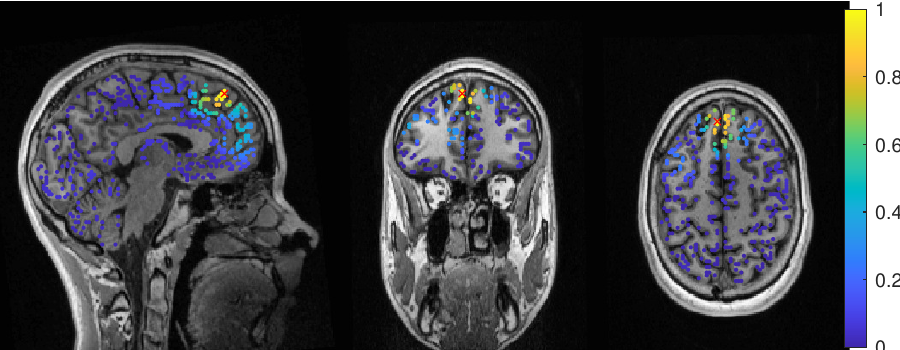
Figure 11. Patient 2’s result of the MEEG average-based beamformer in the 6 compartment head model at 0.05 regularization with sagittal ( left subfigure), coronal ( middle subfigure) and axial ( right subfigure) cuts through T1 MRI and source space. The maximum is additionally marked with a red x. Note that the MRI is not in radiological